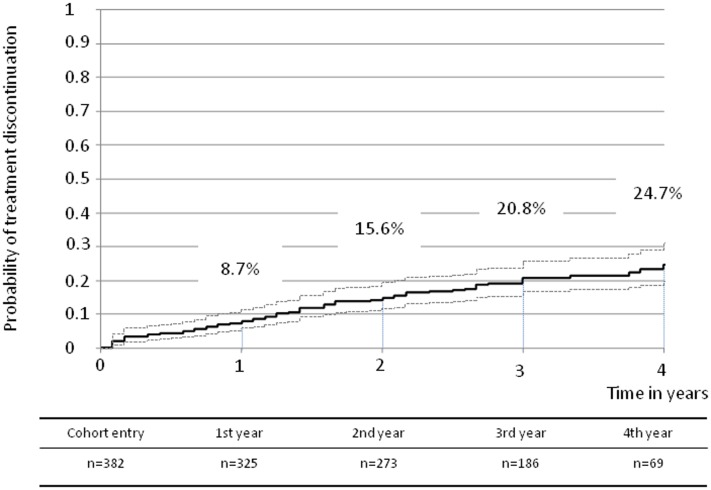
Curves corresponding to cumulative probability of aromatase inhibitor discontinuation with 95% confidence interval (dotted lines) – medication gaps longer than 3 months – ELIPPSE 65 cohort – n = 382.